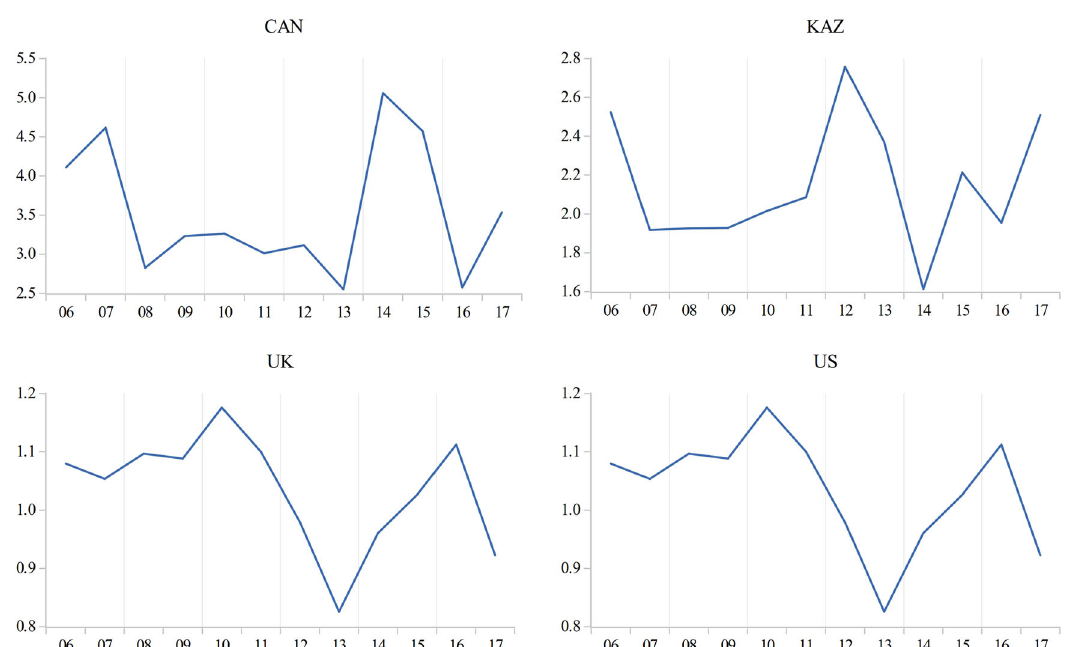
Fig. 3 Time-series plots of SSR for wheat in exporting countries from 2006 to